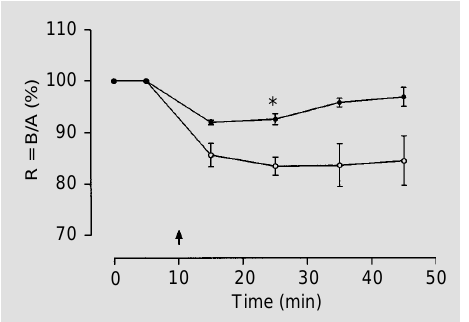
Figure 2 - Tetanic fade induced by 0.75 (filled circles) and 1.5 mg/kg (open circles) nitric oxide (NO) in cat anterior tibial muscle preparations. On the ordinate, the R ratio (B/A) is expressed as a percentage of that obtained 5 min after injection of drug-free saline. NO was injected at time = 10 min (arrow). Drugs were administered through the middle genicular artery. Points represent the mean (± SEM) of 4 to 6 experi- ments. *P<0.05 compared to the R ratio obtained with the intra-arterial injection of 1.5 mg/kg NO.